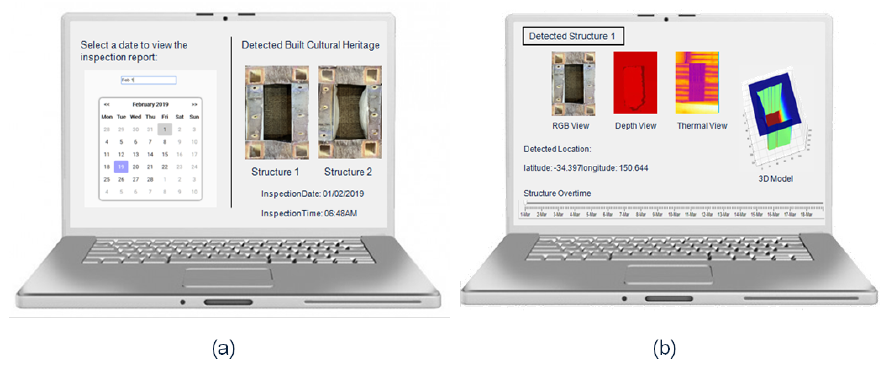
Figure 13. Proposed user interface displaying the detected built cultural heritage during a selected inspection flight and providing the ability to switch between the different views to be able to analyze anomalies in RGB, depth, and thermal scales: ( a ) displays the main view for inspection selection and shows the detected built cultural heritage while ( b ) shows the analysis report of the selected structure over